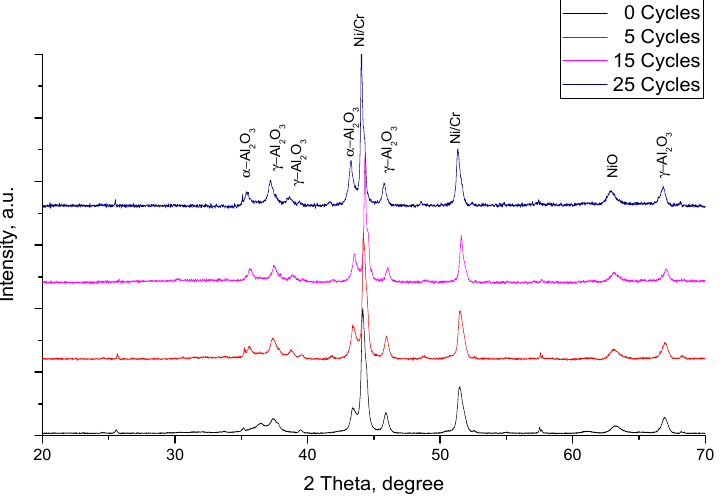
Figure 11. X-ray diffraction patterns of Al 2 O 3 coating before and after heat treatment cycles. The addition of titania improved the stability of the phase composition of alumina coating; therefore, chemical changes after heat treatment experiments were insignificant (Figure 12). The main peaks of α -Al 2 O 3 phase at 2 θ = 35.7 ◦ 43.5 ◦ and 63.1 ◦ and peaks of γ -Al 2 O 3 phase at 2 θ = 37.4° 45.8° and 67.1° were identified. The ratio of the most intense peaks of α -Al 2 O 3 and γ -Al 2 O 3 of Al 2 O 3 -13 wt.% TiO 2 coating before heat treatment was 1.46. After 5 heating cycles the ratio of α -Al 2 O 3 / γ -Al 2 O 3 increased up to 1.67; then, after 15 cycles the ratio dropped to 1.6 and remained roughly the same even after 25 cycles. Similar to Al 2 O 3 samples, the Al 2 O 3 -13 wt.% TiO 2 coating has two peaks of NiCr at 2 θ = 44.3 ◦ and 51.6 ◦ attributed to the bonding layer of NiCr. These results are in good agreement with those of other authors [18,20,25] where no significant phase changes were observed for γ -Al 2 O 3 during annealing of up to 700 °C of plasma-sprayed Al 2 O 3 -13 wt.% TiO 2 coatings. Only minor changes of alpha-alumina phase peaks’ intensities were observed. The results indicate that the addition of titania led to improvement in the stability of phase composi- tion by a noticeable margin although the elemental composition of the sample remained nearly the same. It should be noted that the amount of γ -Al 2 O 3 phase in deposited Al 2 O 3 coating was higher compared to Al 2 O 3 -13 wt.% TiO 2 coating. S. Jia et al. [9] found that the addition of TiO 2 content in Al 2 O 3 feedstock powder reduced the γ -Al 2 O 3 phase content in alumina-titania coatings. This indicates that TiO 2 inhibits the transformation from α -Al 2 O 3 to γ -Al 2 O 3 phase. Thus, with the addition of TiO 2 , transformation of metastable alumina phase to the stable α -Al 2 O 3 phase was promoted. The improved quality of the Al 2 O 3 -TiO 2 coating is due to the lower melting temperature of titania. The liquid TiO 2 was dispersed and filled the holes in the semi-molten alumina matrix. As a result, the as-sprayed coating demonstrated lower stress values and reduced number of cracks and pores and was